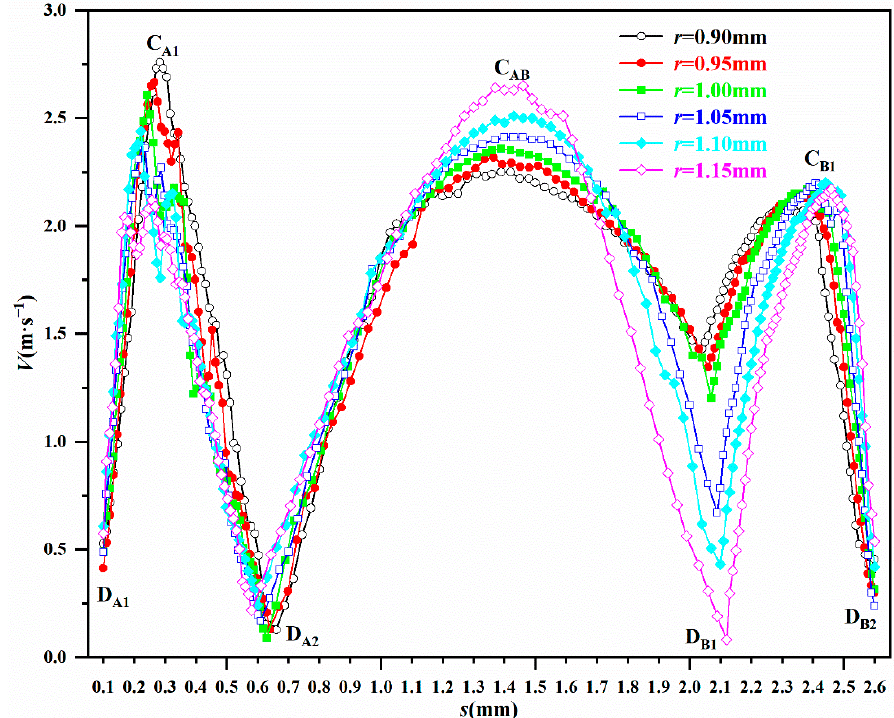
Figure 7. The velocity line diagram of the center line of the mid-depth cross-section for six flow channels.